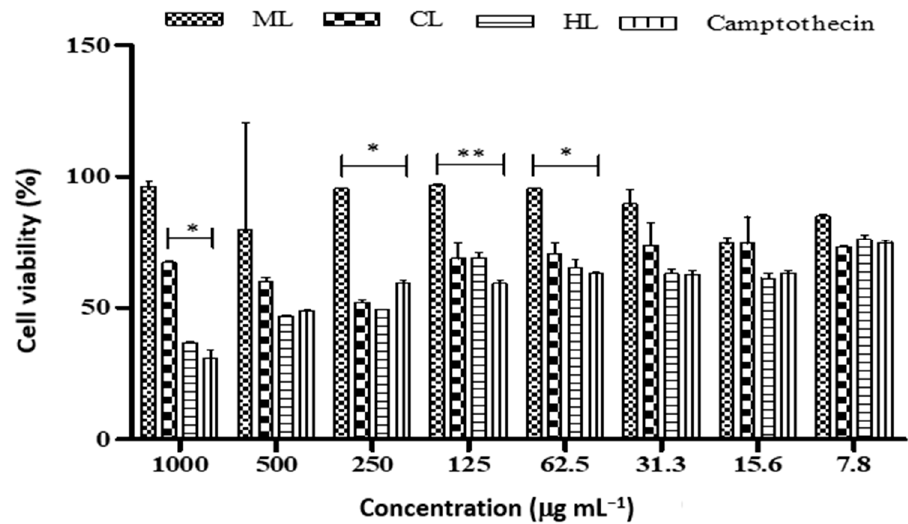
Figure 1. Cell viability of MCF-7 cancer cell line treated with different concentrations of D. villosa leaves. * (Camptothecin vs. CL); (Camptothecin vs. ML); p < 0.05. ** (Camptothecin vs. ML), p < 0.01. The cytotoxicity of MCF-7 cells by both hexane (IC 50 24.57 µg mL − 1 ) and chloroform stem extracts (IC 50 3.919 µg mL − 1 ) (Table 4 and Figure 2) was much greater compared to camptothecin (IC 50 value of 36.54 µg mL − 1 ). However, the greatest anticancer activity produced in MCF-7 cells was demonstrated by the methanolic stem extract (IC 50 0.17 µg mL − 1 ). Table 4. IC 50 values of methanol, chloroform and hexane extract of D. villosa stem against MCF-7 cell.